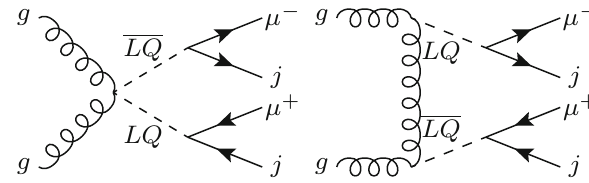
Fig. 3 Example Feynman diagrams of LQ pair production at a hadron collider followed by subsequent decay of each LQ into μ j Table 1 Design centre of mass energies and integrated luminosities of the LHC Run II and future hadron colliders √ s (TeV) L (ab − 1 ) 13